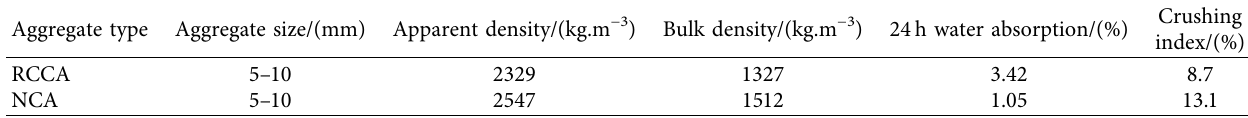
Figure 1: Recycled ceramic coarse aggregate (RCCA), natural coarse aggregate (NCA), and PVA fiber. (a) RCCA. (b) NCA. (c) PVA fiber. Table 1: Basic properties of RCCA and NCA.